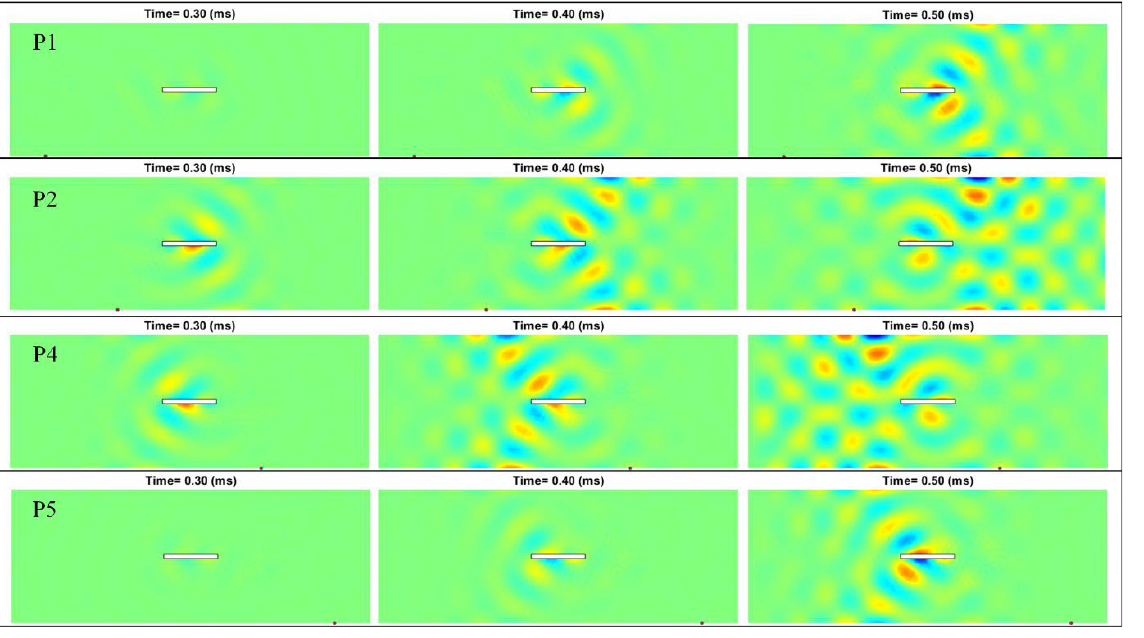
Figure 8. Differential instantaneous wave field when the pointwise excitations are at different loca- tions.